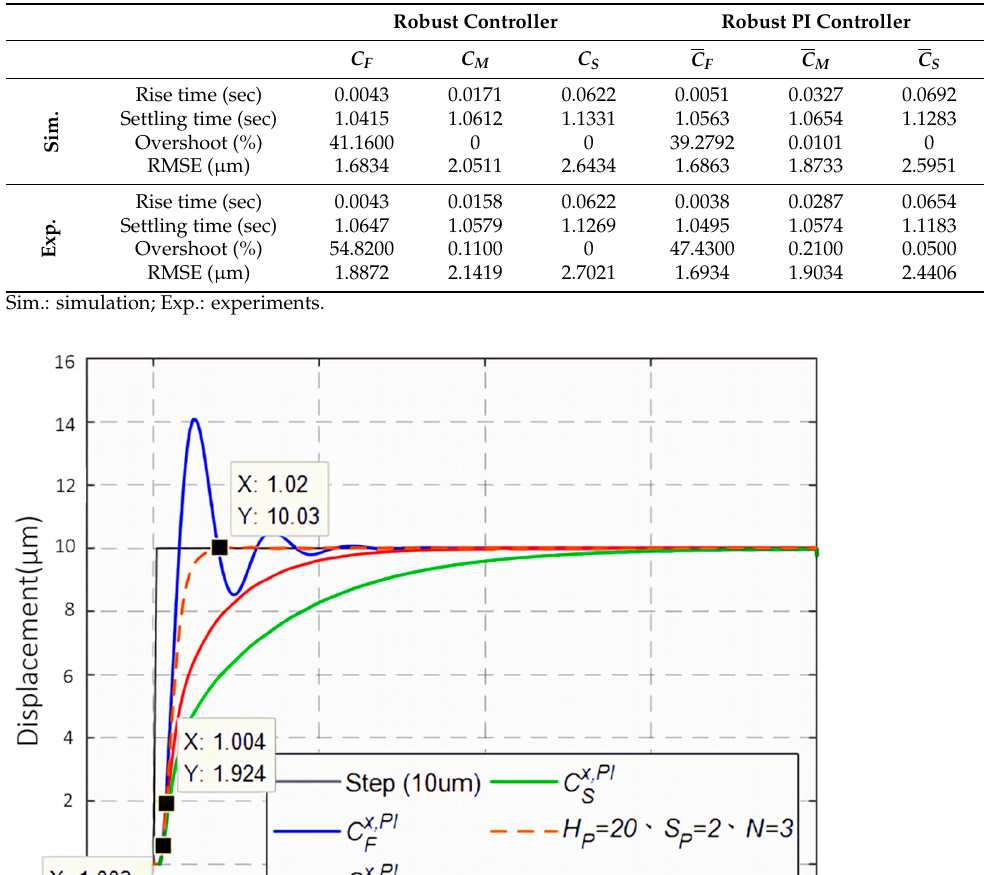
Table 2. Statistical comparison of the controllers.